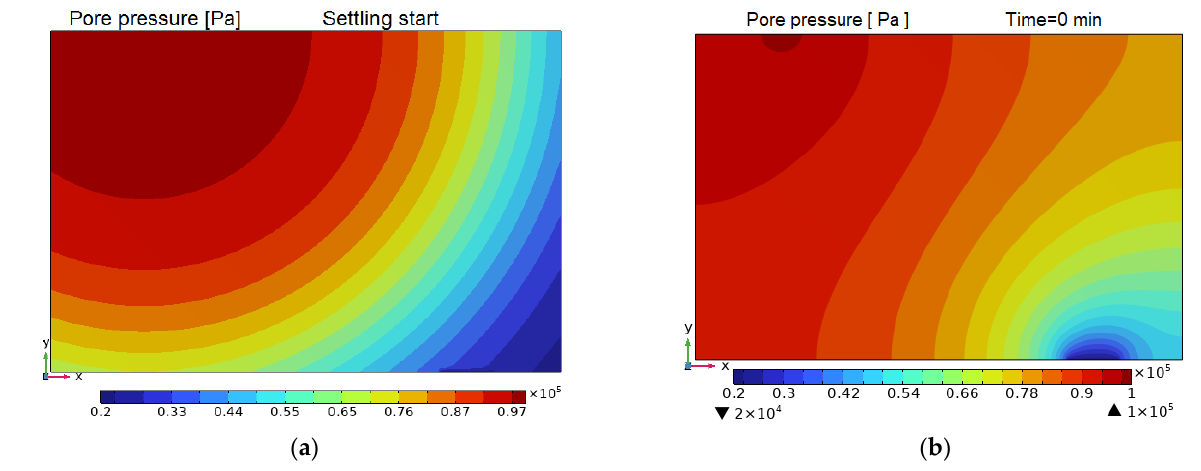
Figure 5. Initial ( a ) and steady state ( b ) pore pressure distributions in the preform before post-infusion exposure to controlled external pressure.